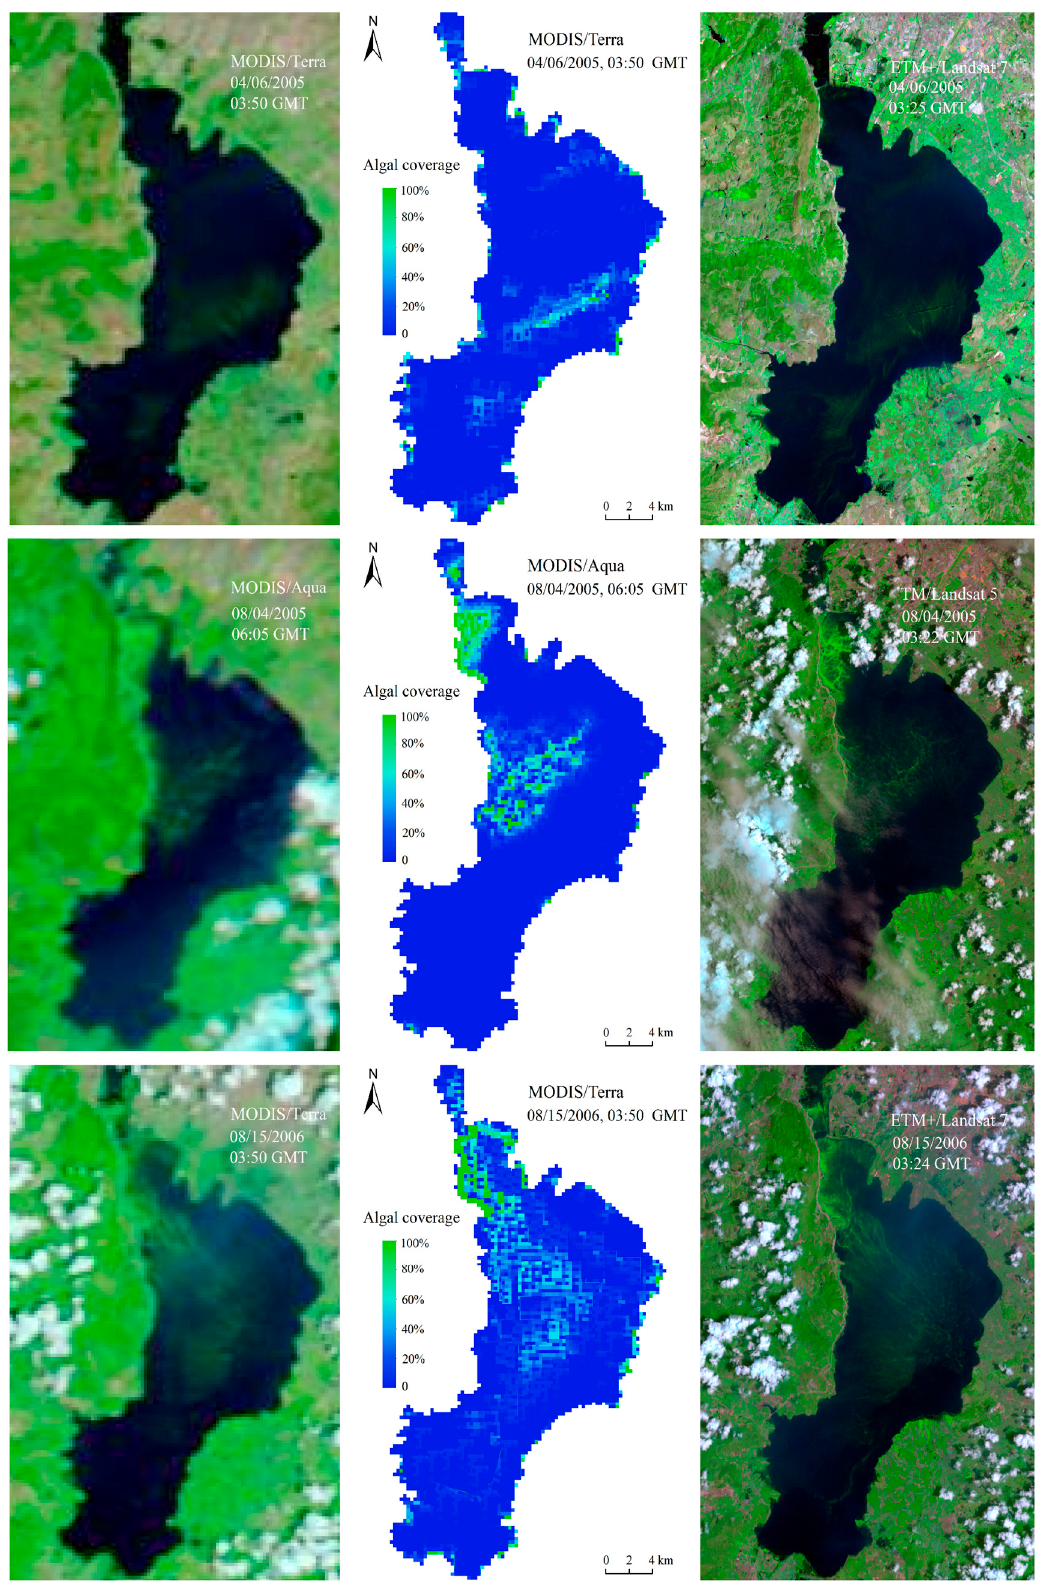
Figure 3. Comparison between algae pixel-growing algorithm (APA) results and Moderate Resolution Imaging Spectroradiometer (MODIS), TM/ETM+ false color composites.